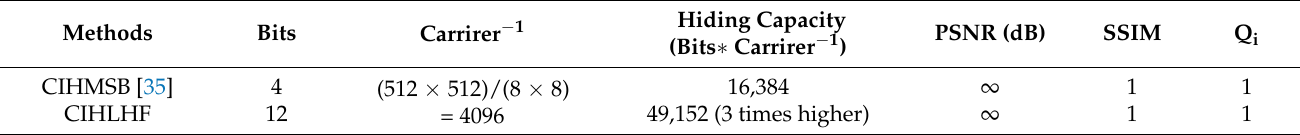
Table 3. Performance comparison of CIHMSB and CIHLHF.